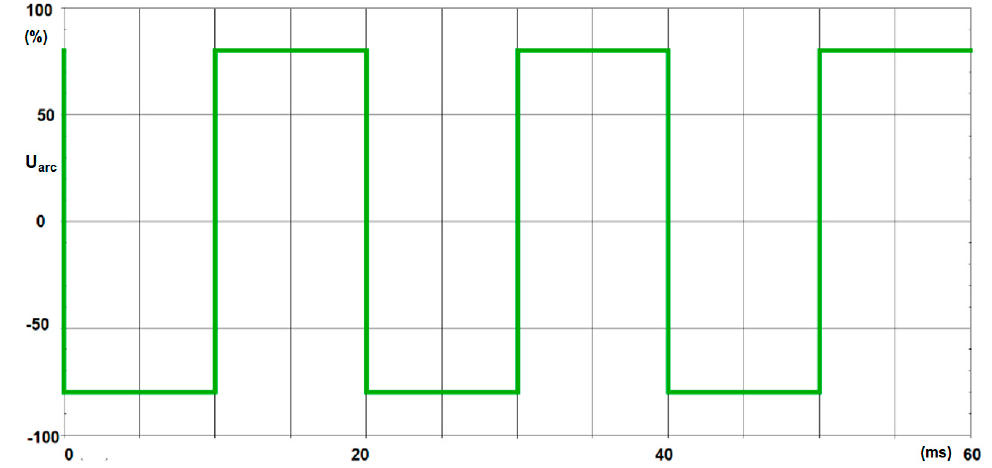
Figure 23. Waveform of a rectangular arc voltage for a multi-voltage model.